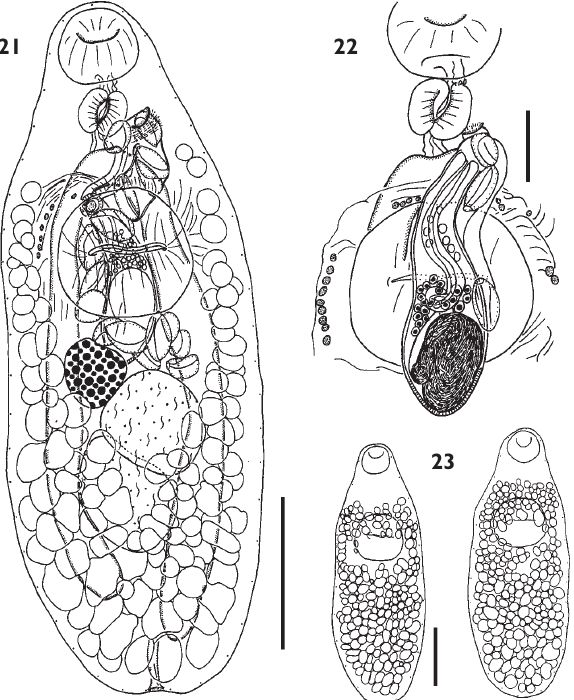
Figs 21-23. Macvicaria vitellocopiosa n. sp. ex Sillaginodes punctatus . 21. Whole-mount ventral view. 22. Terminal genitalia. 23. Dorsal distribution of vitelline follicles. Scale bars : 21, 23, 250 μm; 22, 100